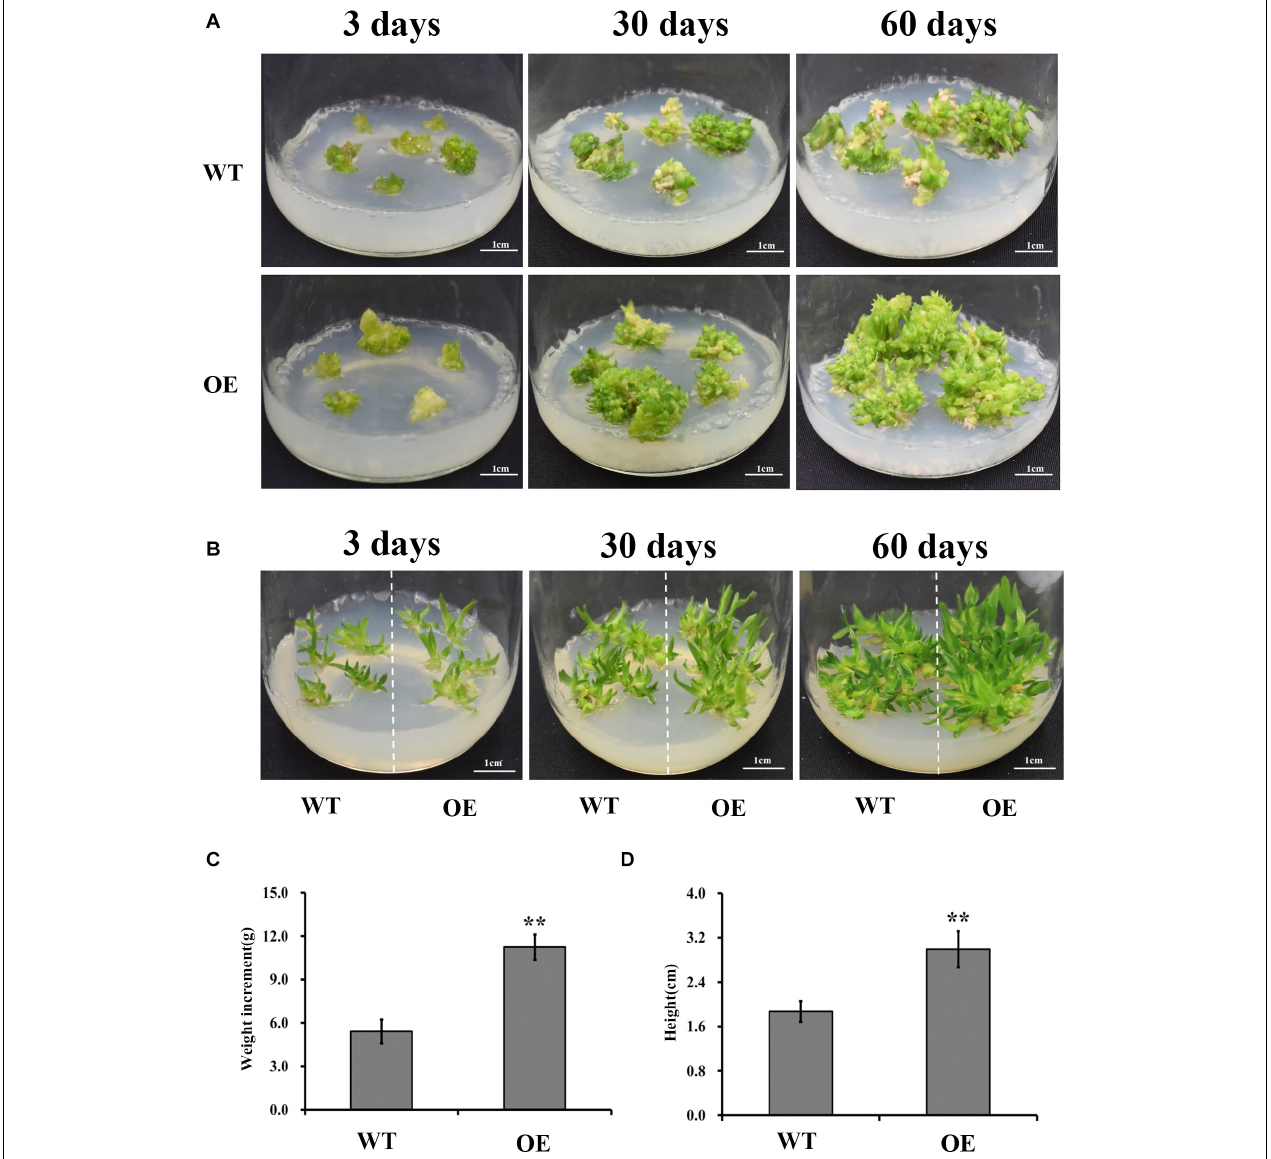
FIGURE 2 | Growth performance of DoUGP overexpression (OE3) plants. Protocorms (A) and seedlings (B) were imaged when they were cultivated on MS medium for 3, 30, and 60 days, respectively. For weight (C) measurement, during 60 days, weight increment of protocorms from three independent culture flasks were investigated. For height (D) measurement, seedlings from three independent culture flasks were investigated after 60 days. Results are presented as mean ± standard error calculated from three biological replicates. Asterisks indicate statistically significant